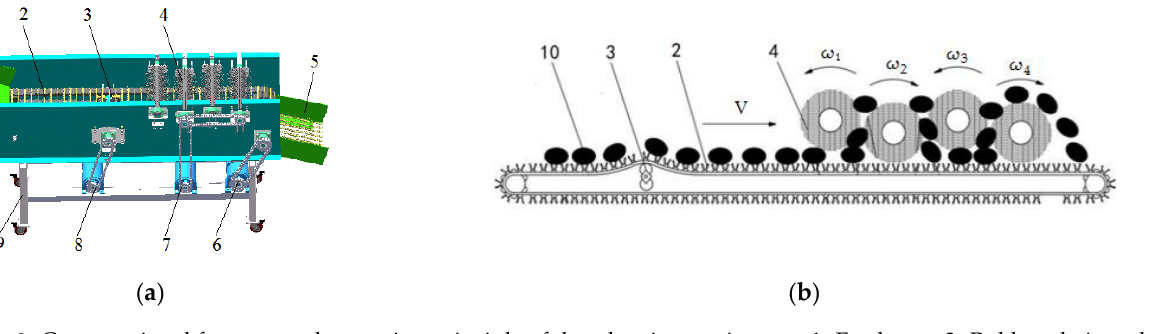
Figure 3. Constructional features and operating principle of dry-cleaning equipment; 1. Feed port; 2. Rubber chain rod mechanism; 3. Shaking mechanism; 4. Four groups of brush roller mechanism; 5. Discharge port; 6. Drive system of the rubber chain rod mechanism; 7. Drive system of the four groups of brush roller mechanisms; 8. Drive system of the shaking mechanism; 9. Frame; 10. Potato. ( a ) Structure of dry-cleaning equipment; ( b ) Principle of dry-cleaning equipment. Note: the ω 1 , ω 2 , ω 3 , ω 4 is the rotation direction of brush roller, and V is the movement direction of potatoes and rubber chain rod mechanism.